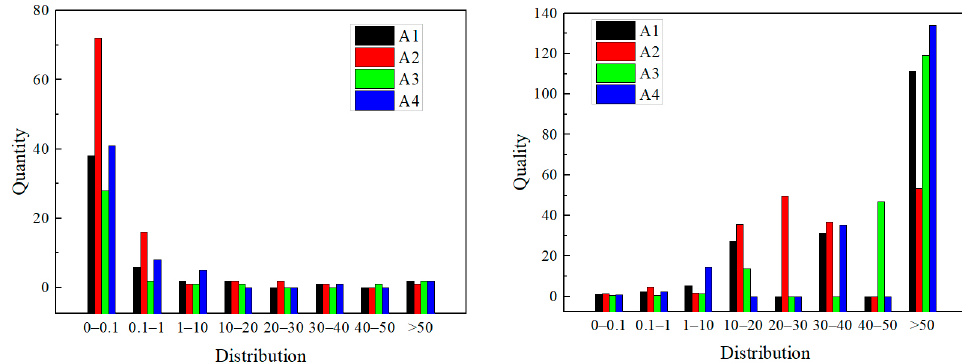
Figure 5. Distribution of block numbers and block masses.